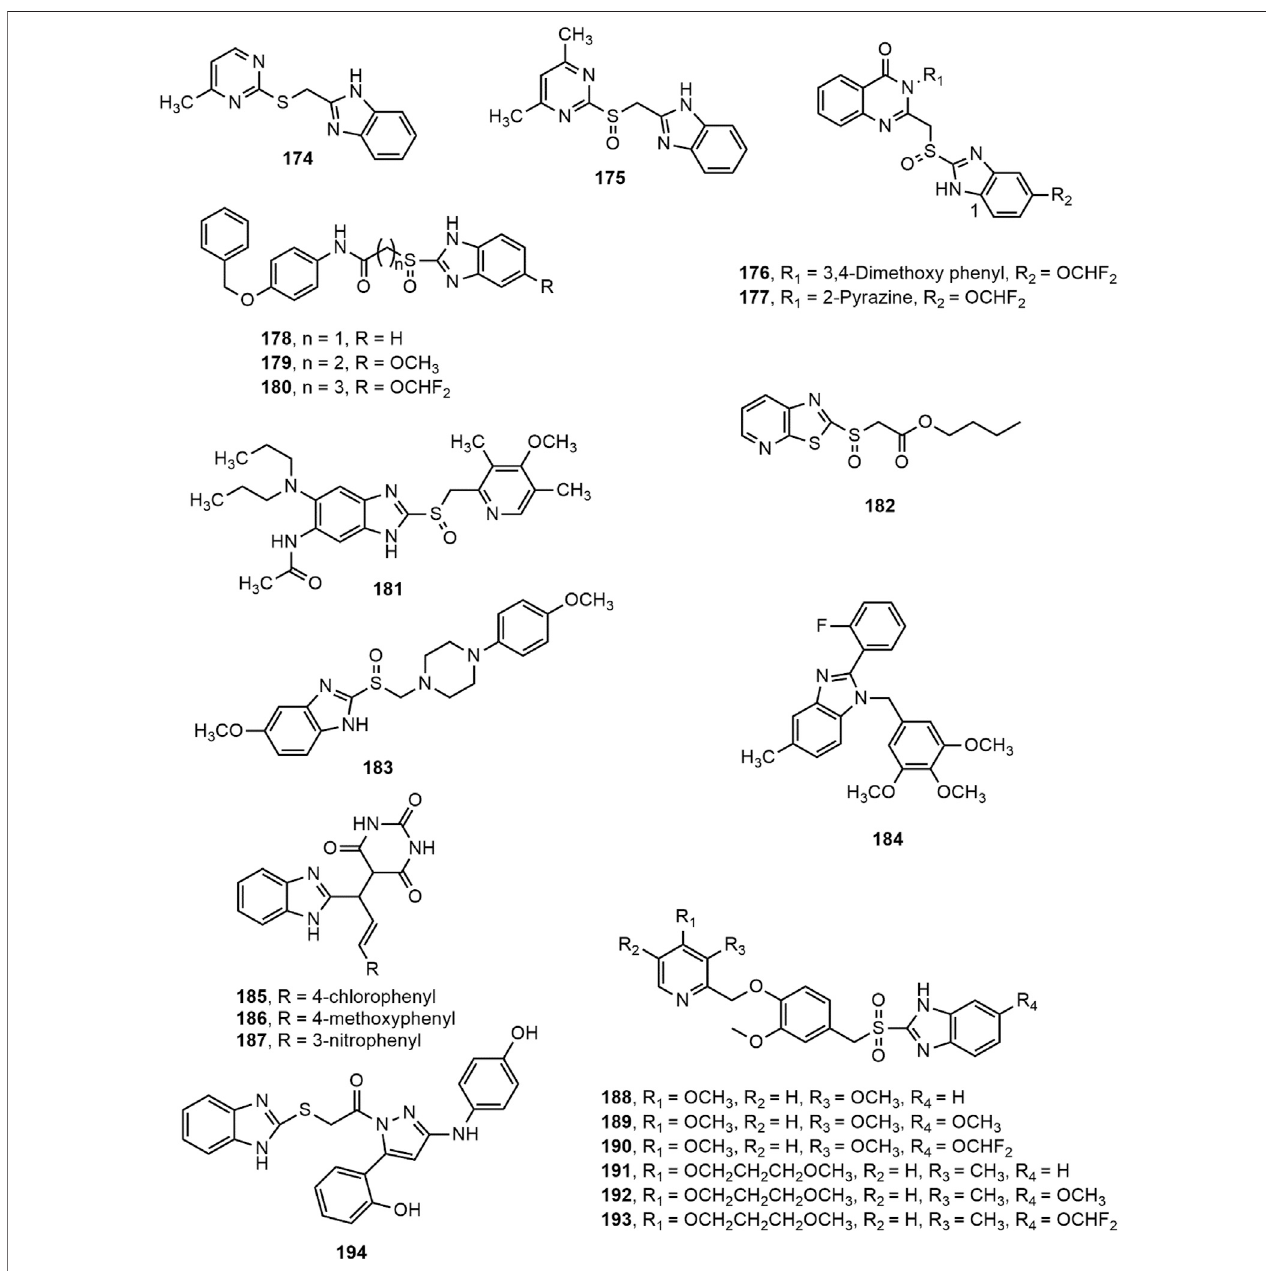
FIGURE 7 | Benzimidazole derivatives with antiulcer